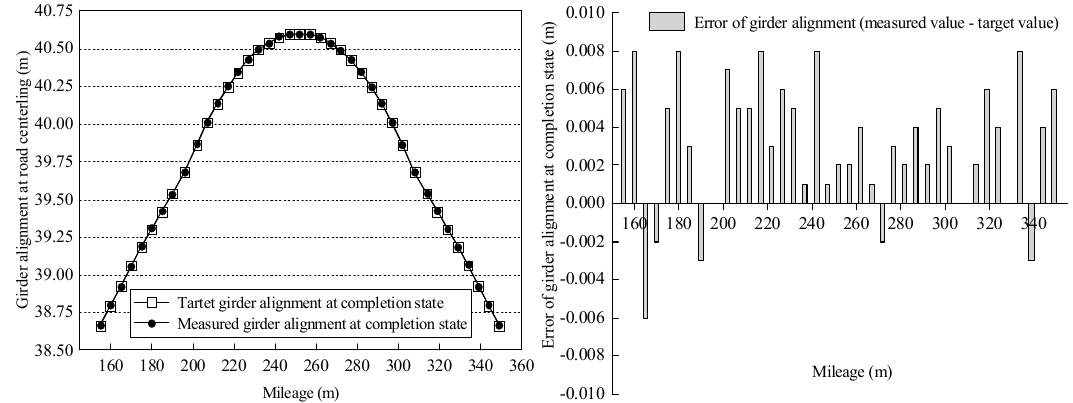
Figure 19. Measured error of the final hanger force. Figure 20. Comparison of the final c able alignment.